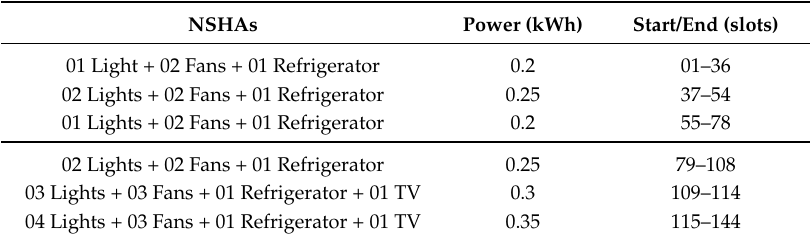
Table 6. Non-shiftable home appliances considered for